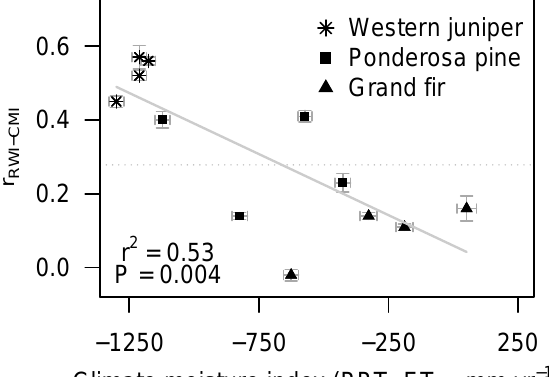
Figure 5. Mean ecosystem-weighted correlation ( RWI-CMI ) be- tween annual tree-ring-width indices (RWI) and the climate mois- ture index (CMI = PPT–ET 0 ) plotted against the 50-year mean ( ± 1SE) growing-year CMI. The dashed horizontal line denotes sta- tistical significance at α = 0.05. The 12 sites were located in the eastern Cascade Mountains and represented forest types dominated by western juniper, ponderosa pine and grand fir. Regression coef- ficients are given in Table